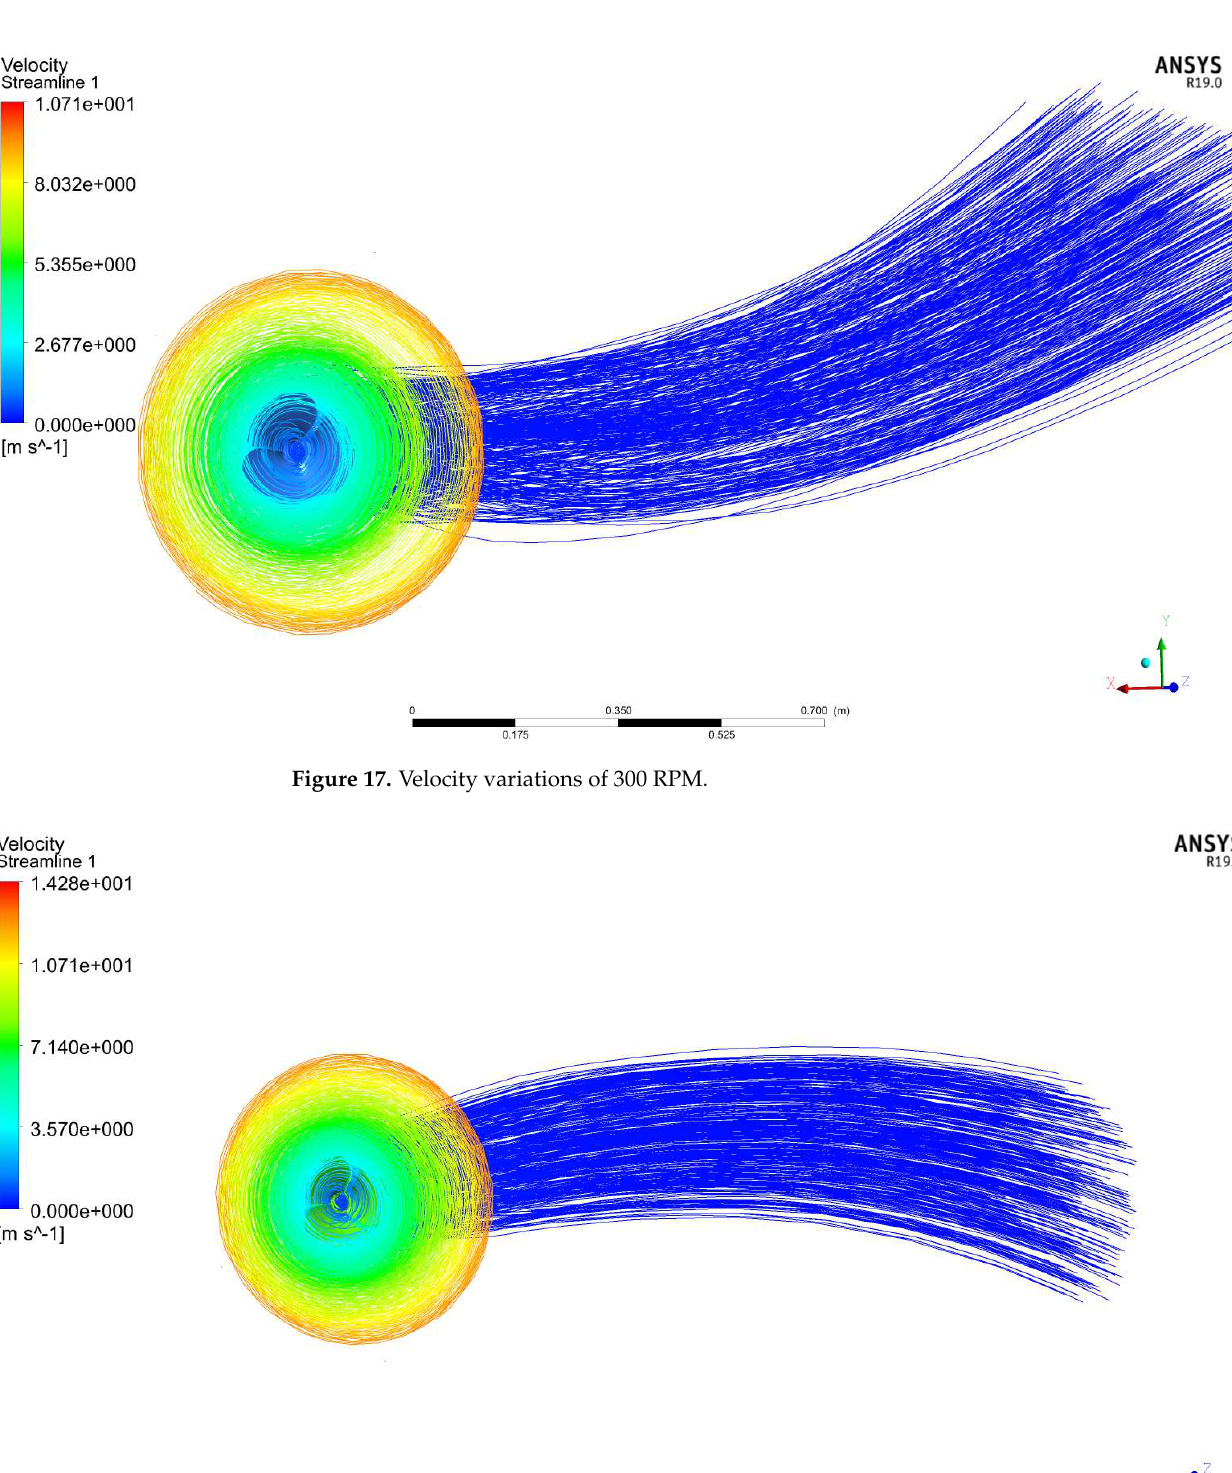
Figure 16. Velocity variations of 200 RPM.